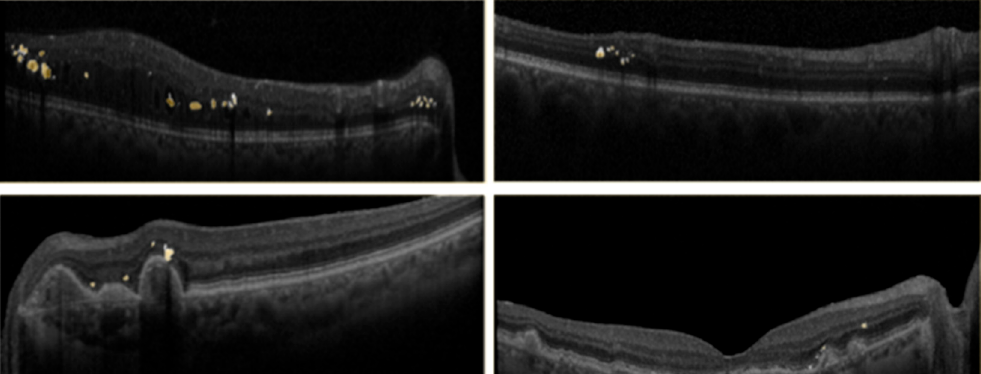
Figure 5. Example HRF segmentation results. Yellow is the prediction over white ground truth an- notations.